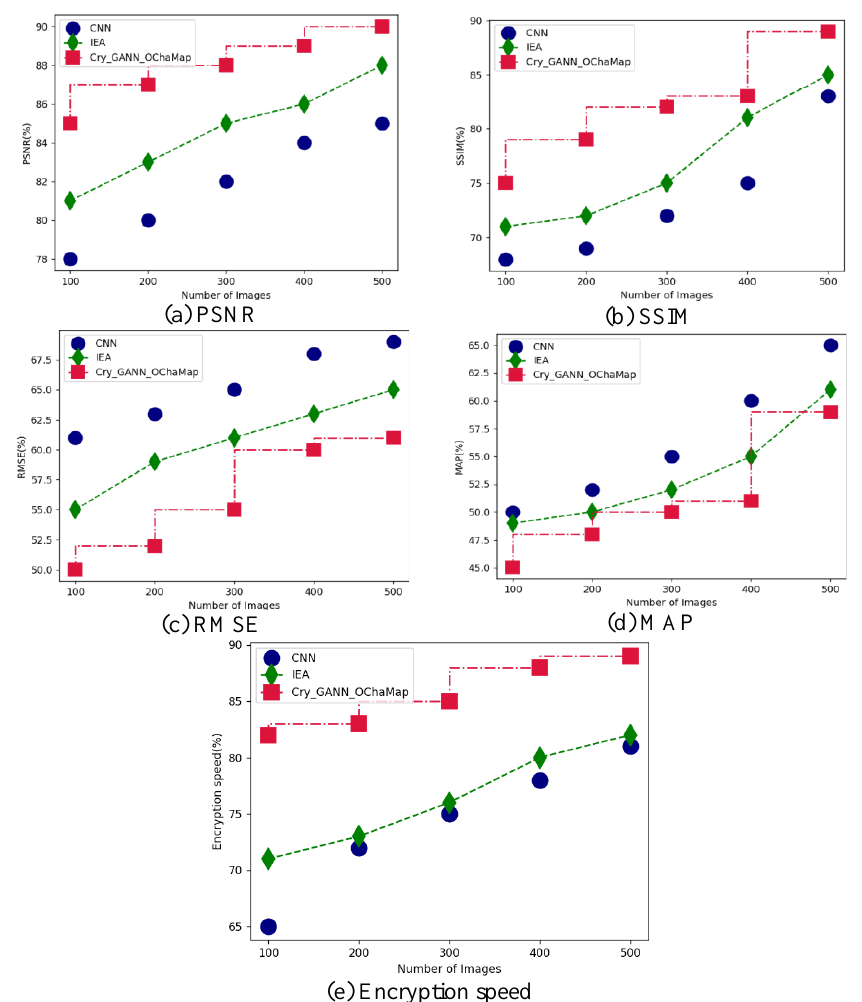
Figure 6. Comparative analysis between the proposed and existing techniques for the LFW dataset in terms of ( a ) PSNR, ( b ) SSIM, ( c ) RMSE, ( d ) MAP, and ( e ) Encryption speed.